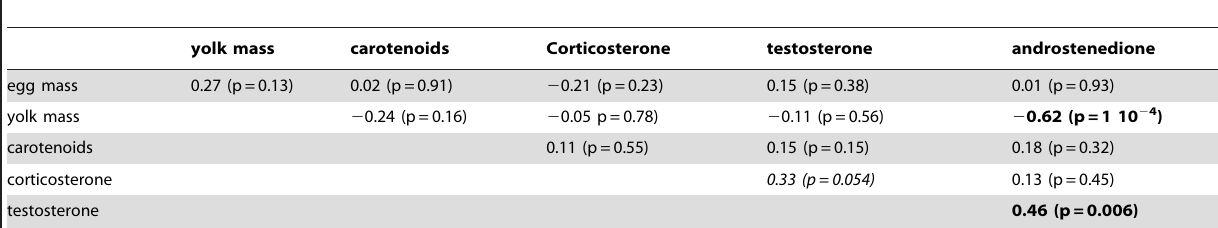
Table 1. Pearson correlations and associated p-values between egg mass and components of the first laid eggs.